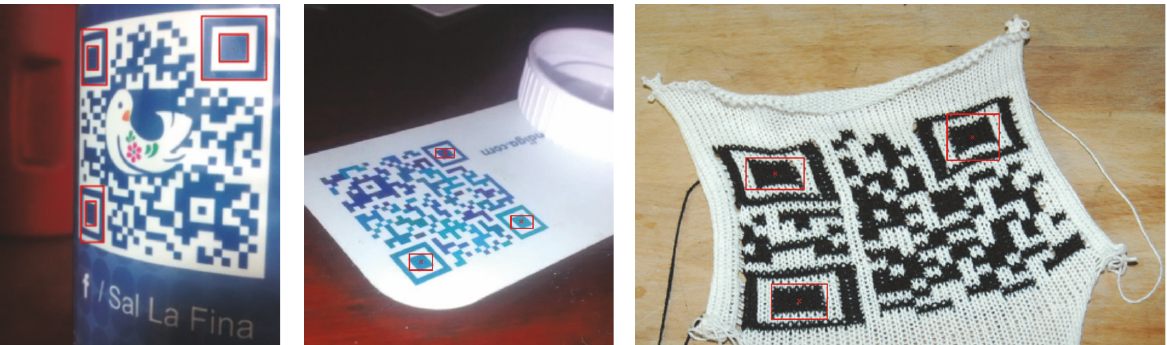
Figure 8: Detection of PDPs of QR code with variable illumination, rotation, and